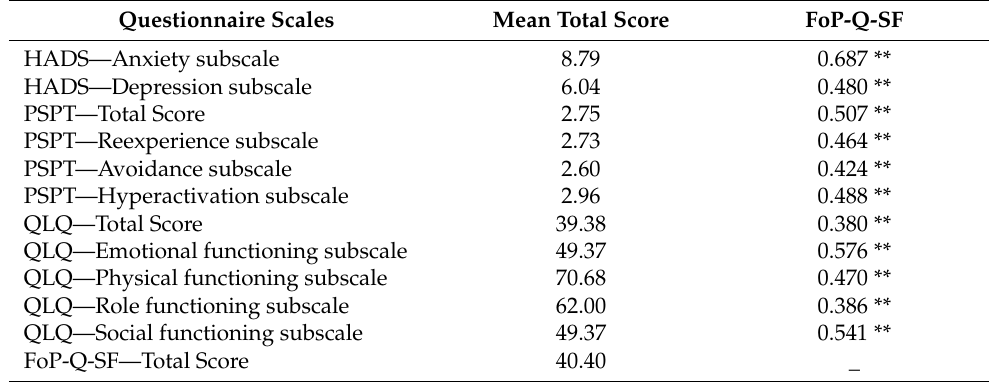
Table 3. Convergent validity: correlations between Fear of Progression (FoP-Q-SF) and Distress (HADS-D and HADS-A), quality of life sub-dimensions and post-traumatic stress